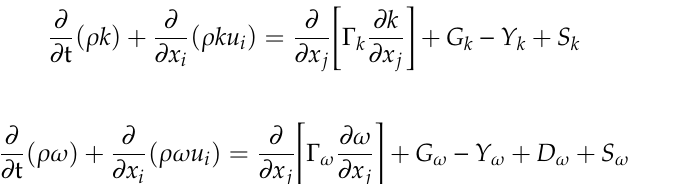
Table 1. Boundary conditions.